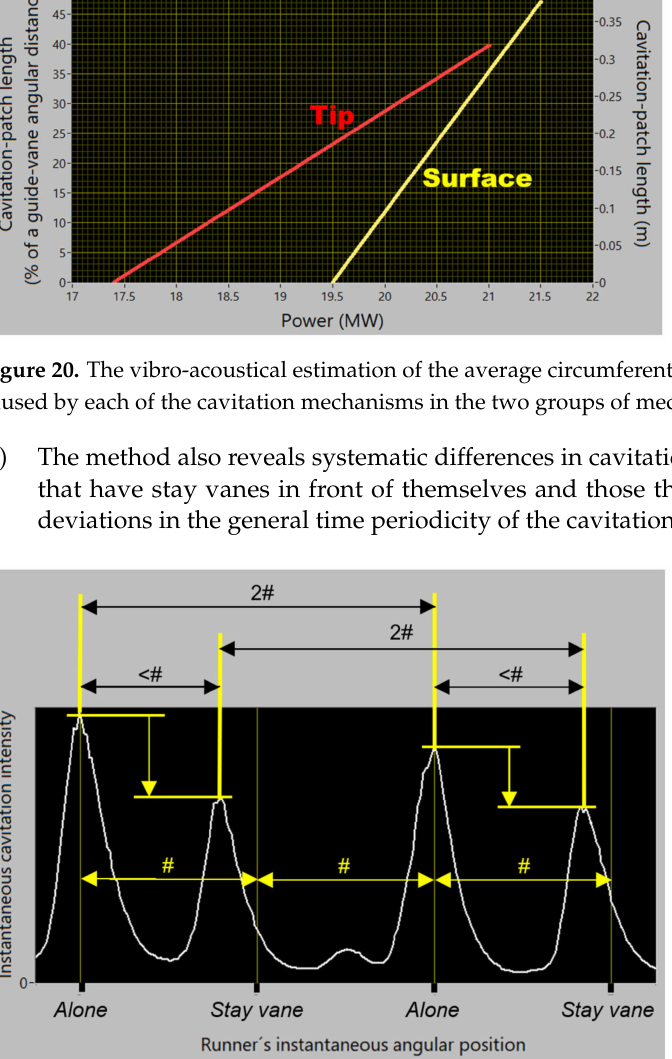
Figure 21. (a) The cavitation intensity stemming from the guide vanes that stand alone is higher than from those that lie behind the stay vanes. (b) The delay between the peaks in an alone/not alone pair is shorter than the mean delay between the guide vanes, #. (c) In the response of one runner blade to the excitation coming from the guide vane, this mean period, #, is ca 20% shorter than the runner rotation